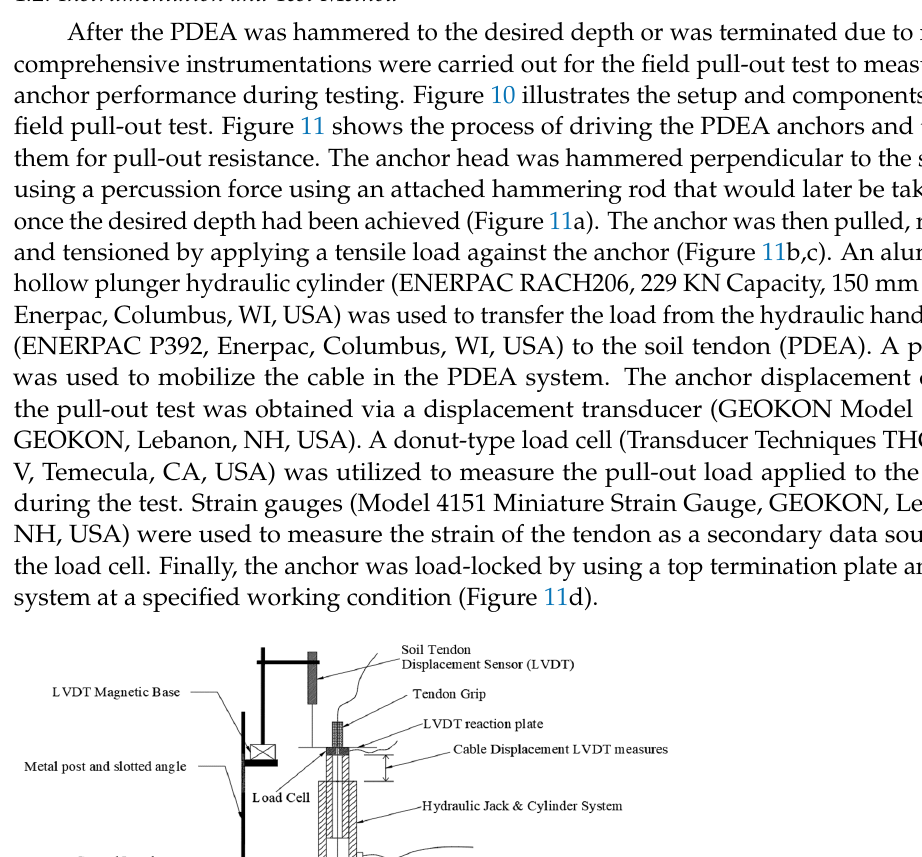
( d ) Figure 11. Illustration of PDEA anchoring and testing process: ( a ) anchor driven, ( b ) pullout test setup, ( c ) pullout test (anchor rotation), and ( d ) anchor locking and finish surface of slope. 5. Results and Analysis 5.1. Field Pull-Out Test Results According to Platipus Anchors Brochure [31], the load–displacement curve for the pull-out test typically goes through three major stages. The first stage is the repositioning and load-locking stage, where the anchor repositions to a horizontal position when subjected to pull-out loads. This stage typically occurs at lower loads of up to 2.2 kN, as observed in this study. The second stage of the pull-out test includes more loading and compaction of soil above the anchor. This stage produces high resistance while the anchor